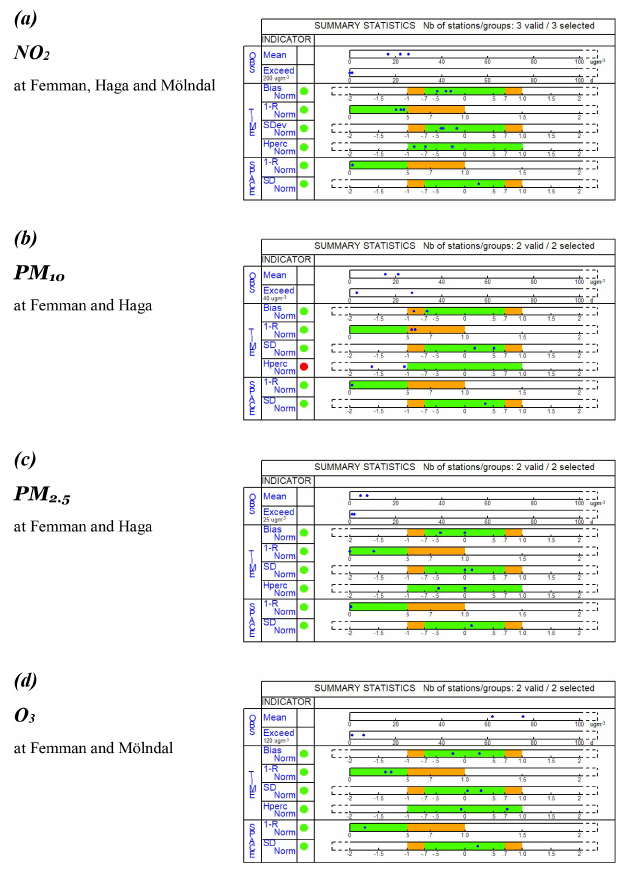
Figure 5. Summary statistics of model performance for the annual mean values of (a) NO 2 (hourly values), (b) PM 10 (daily values), (c) PM 2 . 5 (daily values) and (d) O 3 (daily maximum of the 8h means), including days of exceedances. Stations (blue dots) within the green bars: performance criteria satisfied; stations within the or- ange bars: performance criteria satisfied, error dominated by the corresponding indicator. Green light: >90% of the stations fulfil the performance criteria. Red light: <90% of the stations fulfil the performance criteria. The indicator H perc indicates the model’s ca- pability of reproducing extreme events, represented by a selected high percentile for modelled and observed